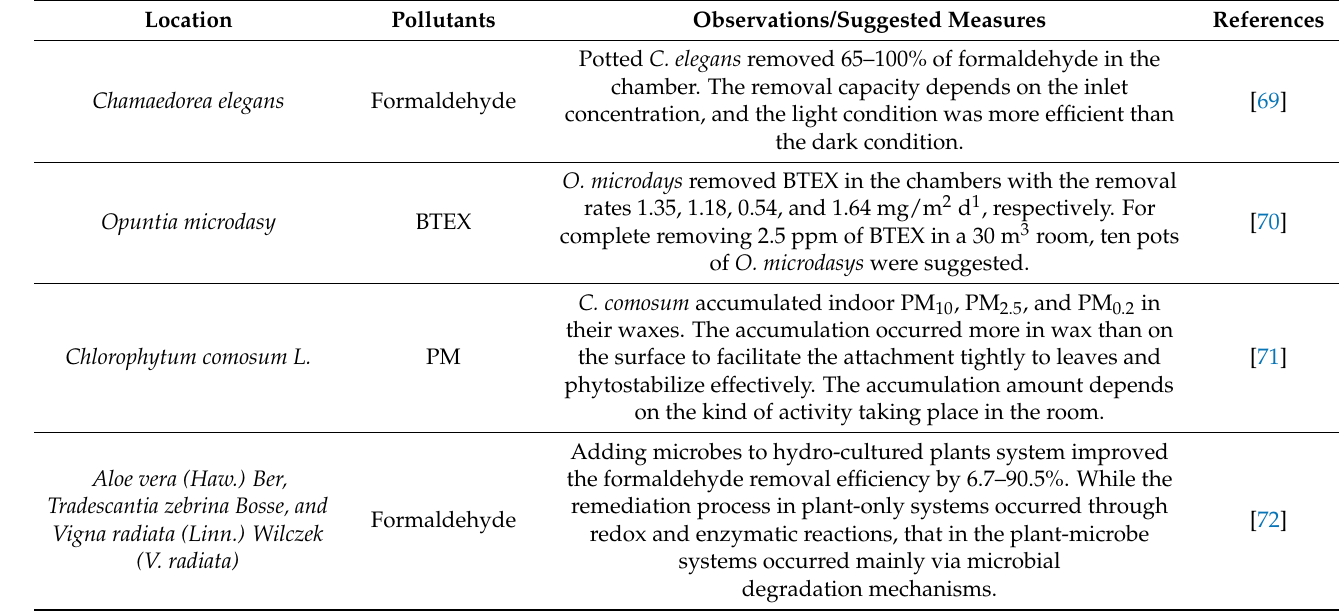
Table 2. Phytoremediation for improving indoor air